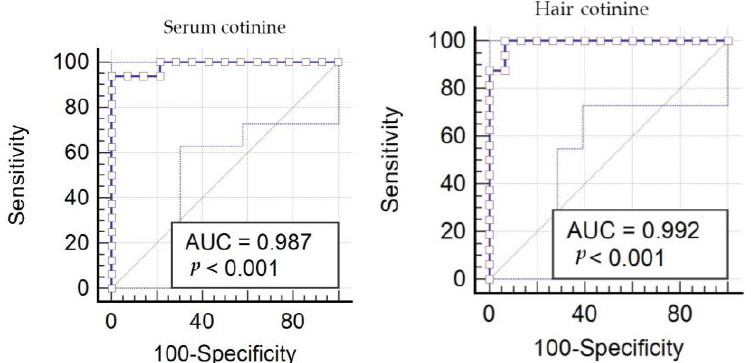
Figure 3. Cutoff values of cotinine concentrations in serum and hair. In the EX group, bitches showed cotinine concentrations that were higher (7.3 ± 5.2 ng/mL) than male dogs (2.7 ± 0.9 ng/mL; p < 0.001) in hair, while no sex differences were recorded in serum. In the EU group, bitches had lower cotinine concentrations (0.8 ± 0.4 ng/mL in serum; 0.7 ± 0.1 ng/mL in hair) than males (1.9 ± 0.4 ng/mL in serum; 1.1 ± 0.3 ng/mL in fur) in both matrices ( p < 0.01). The other parameters, such as the intensity of tobacco smoke exposure, age, and weight, did not influence the cotinine concentration in serum and hair (Table 2). Table 2. Cotinine concentrations. Parameter